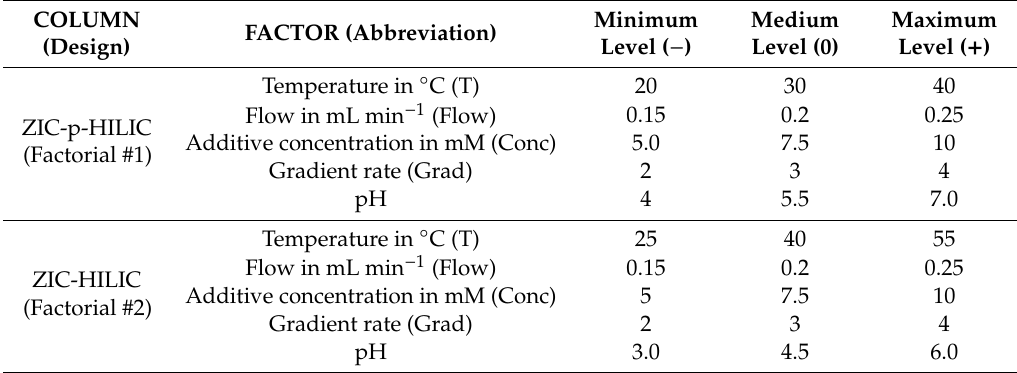
Table 1. Detailed description of the factorial designs for ZIC-p-Hydrophilic Interaction Liquid Chromatography (ZIC-p-HILIC) and ZIC-HILIC